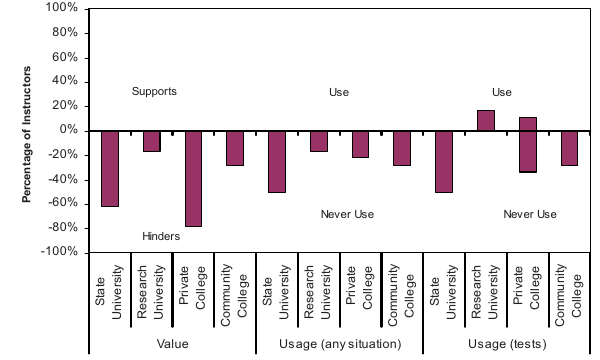
FIG. 8. (cid:1) Color (cid:2) Institutional distribution of the value and usage of multiple-choice questions related to the teaching goal of moni- toring students’ thinking.